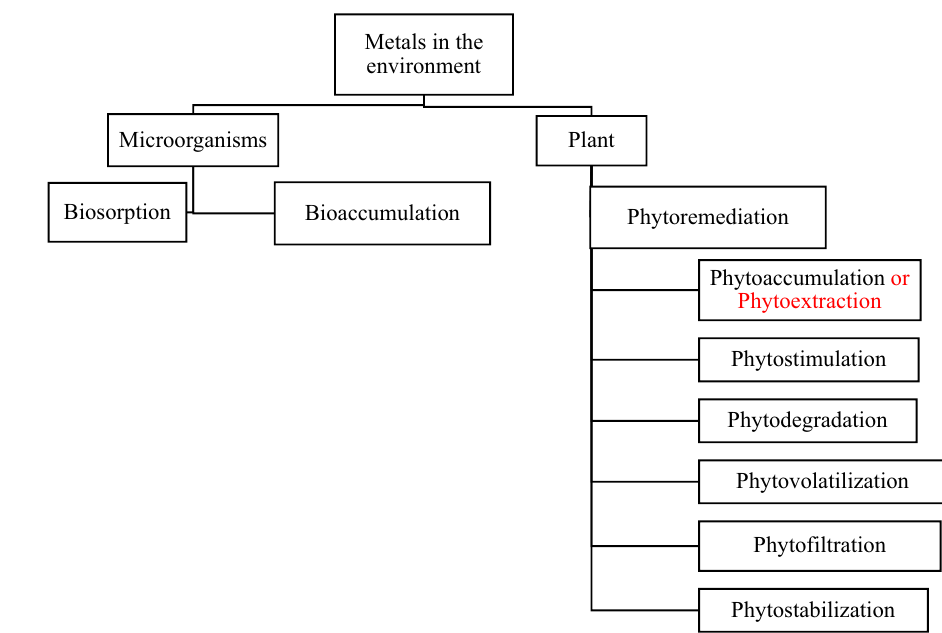
Fig. 2 Biological methods for removal of